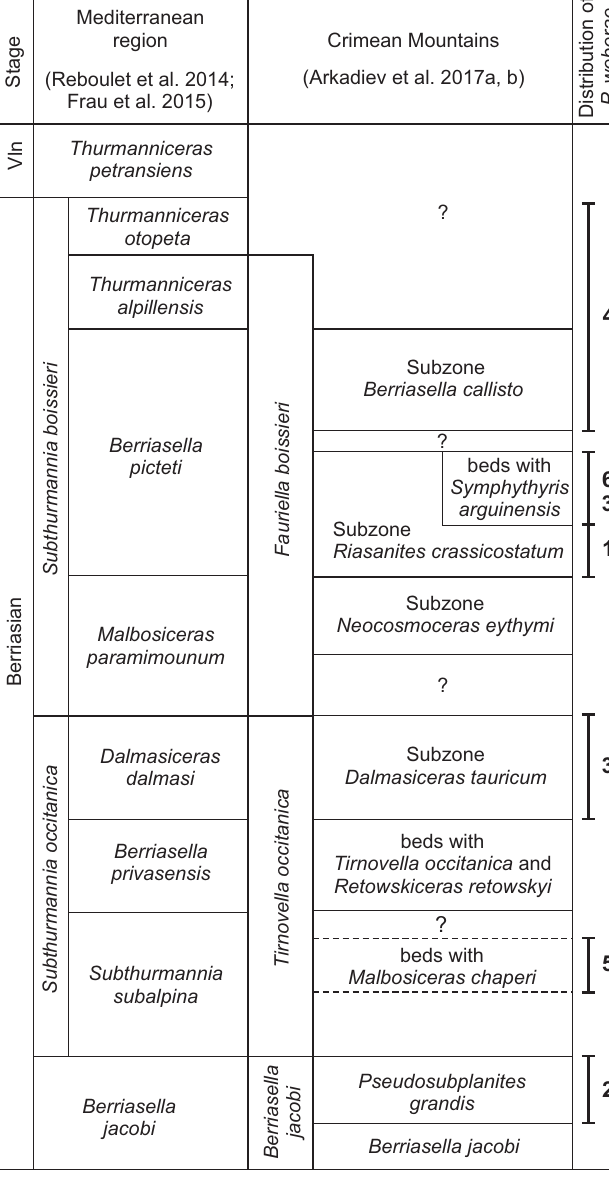
Fig. 3. Subdivision of the Berriasian stage from Crimean Mountains cor- related along with Mediterranean basin, and associated distribution of the species Pycnogryphaea weberae from the different localities. 1, Cherno- kamenka village; 2, Sarysu river; 3, Balki village; 4, Mezhgorye village; 5, Solnechnoselye village; 6, Kuchki village; Vln, Valanginian. Stratigraphy after Arkadiev et al. 2017a,